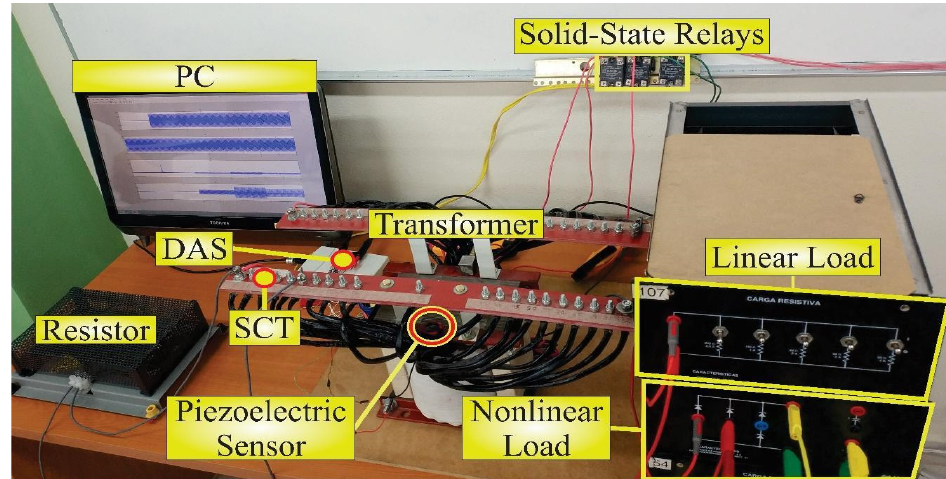
Figure 3. Experimental setup.